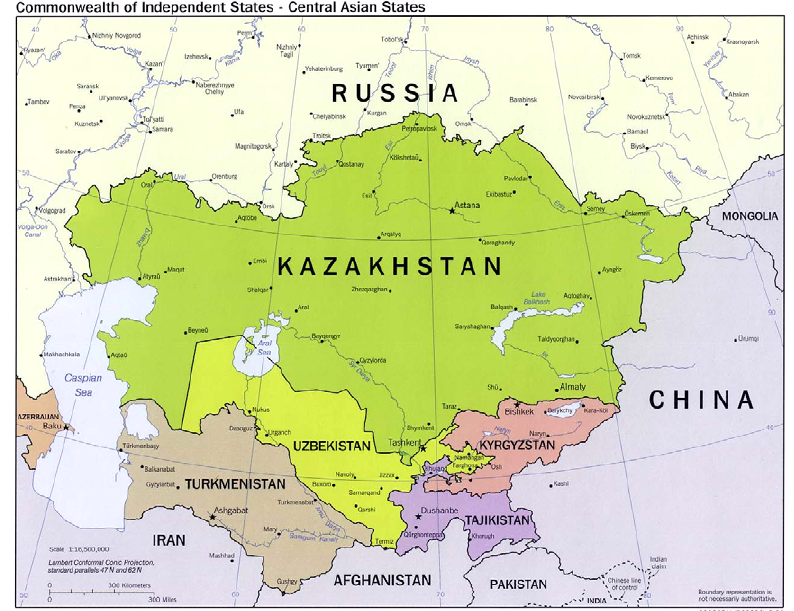
Figure 1. Commonwealth of Independent States - Central Asian States. Courtesy of the University of Texas Libraries, The University of Texas at Austin. Map available at: http://www.lib. utexas.edu/maps/commonwealth/central_asian_common_2002.jpg.